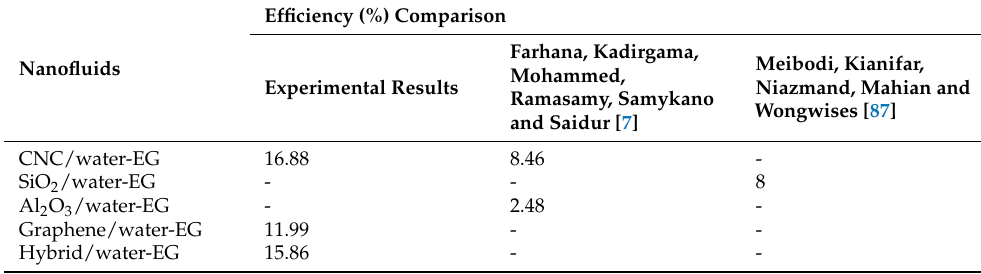
Table 4. Comparison of efficiency with previous